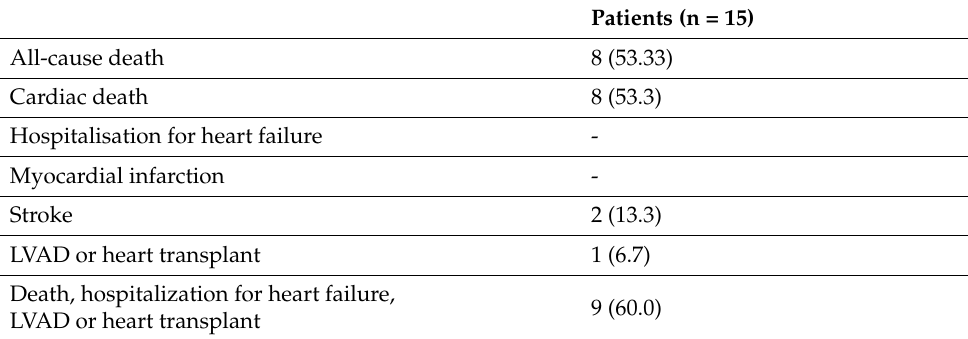
Table 5. One-year